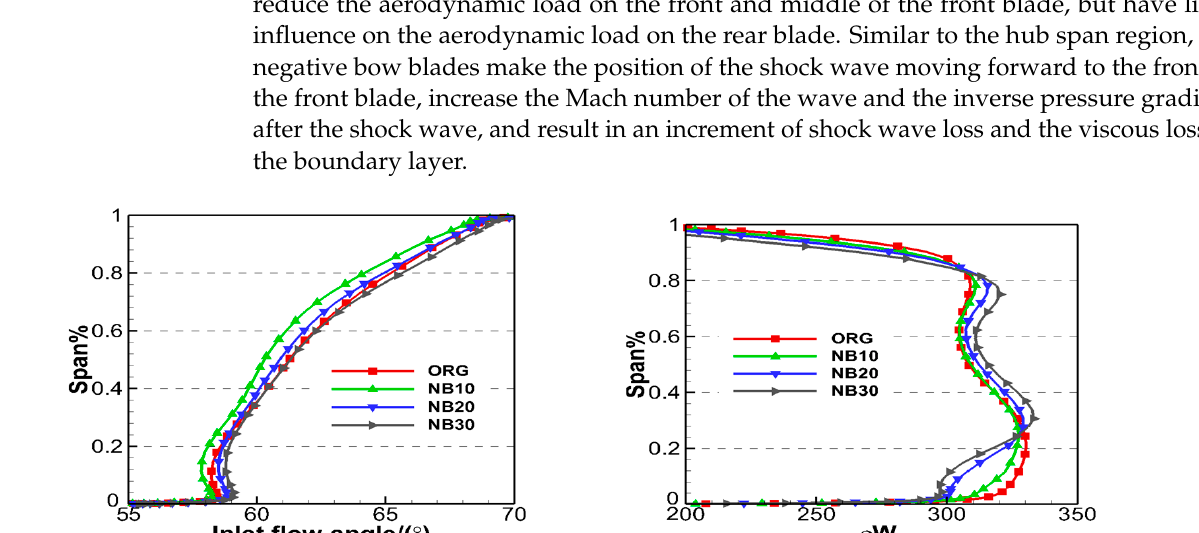
Figure 9. Comparison of spanwise distribution of the inlet flow angle and the axial velocity density (AVD) of NB10, NB20, and NB30. ( a ) the inlet flow angle. ( b ) the axial velocity density (AVD).